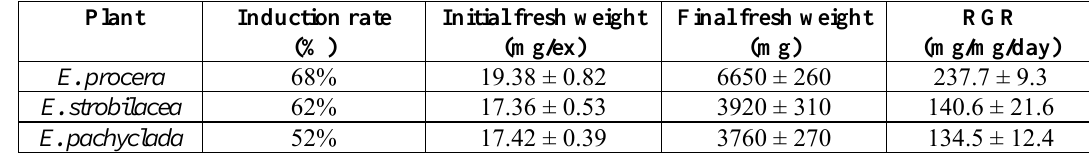
Table 1. Effect of chosen hormonal range for Ephedra